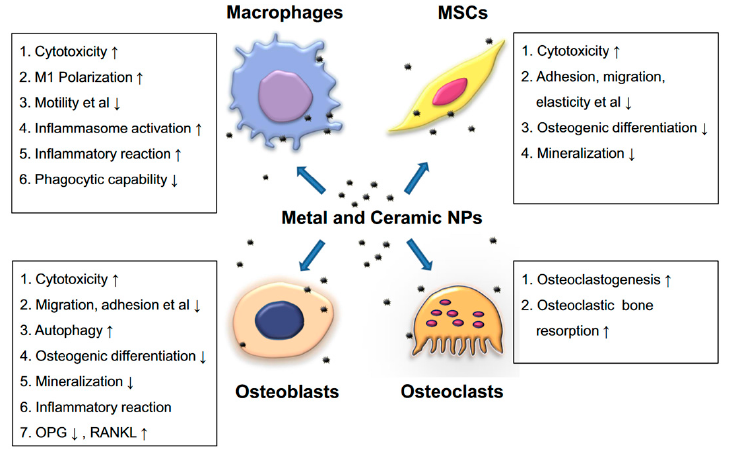
Figure 1. The particles’ drawbacks and negative effects on the cell functions at the implantation site [46] .